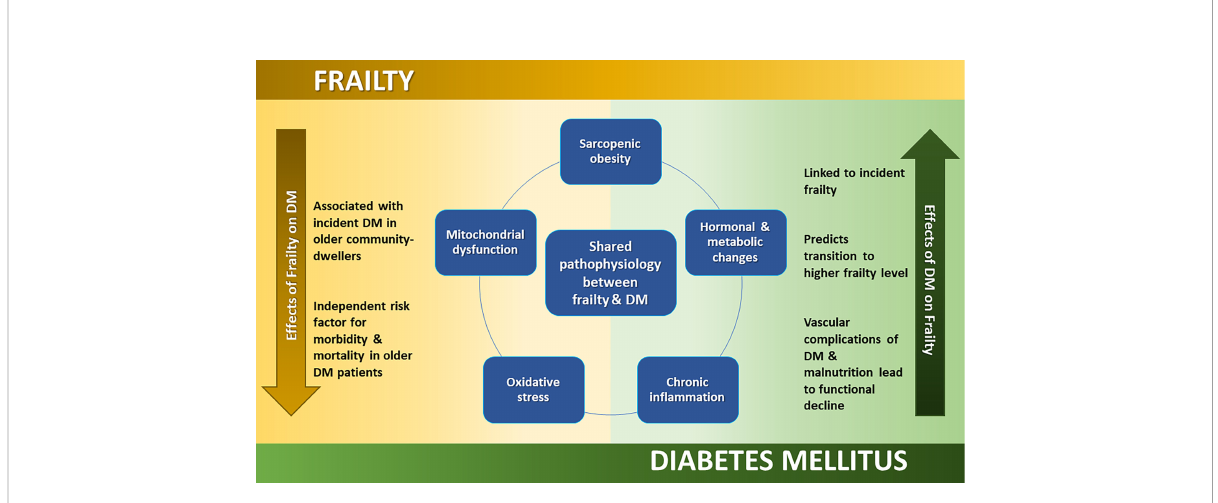
FIGURE 1 Diagram 1. Overview of shared pathophysiology and differential outcomes of DM and